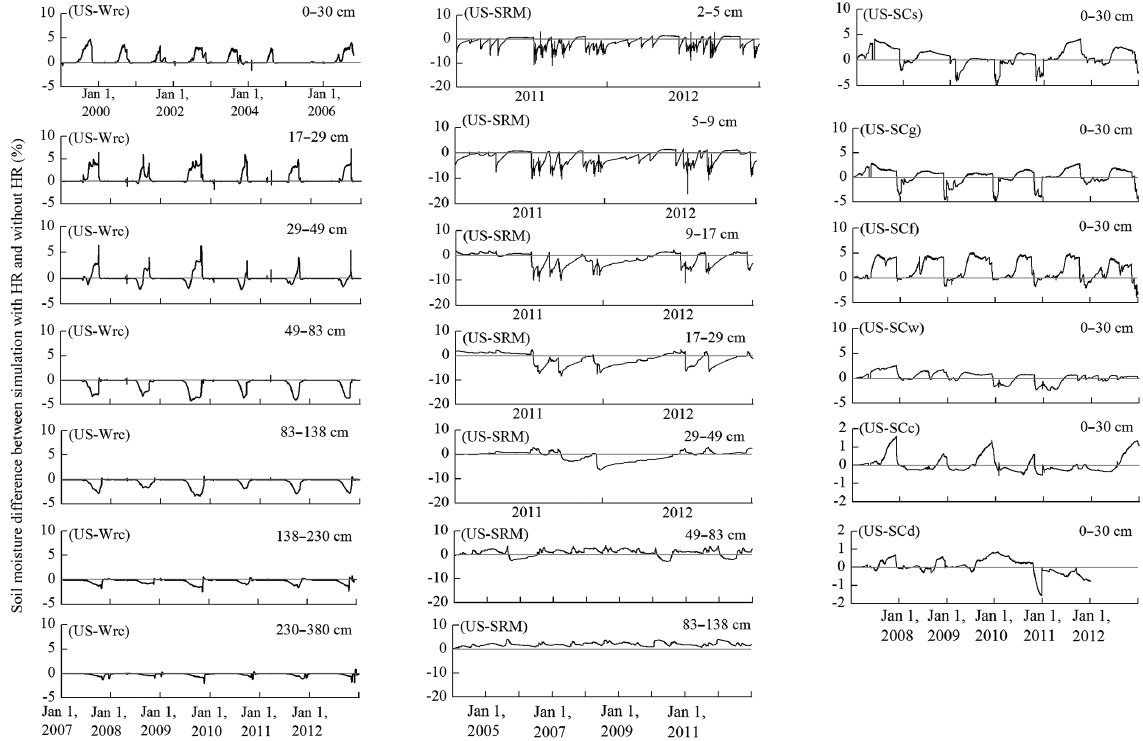
Figure 3. Soil moisture difference between simulations with HR and without HR at each site. Labels at the upper right corner of each panel show the depths of simulated soil moisture. Table 6. Modeled contribution of HR to ET during dry periods for all simulation years (mean ± SD, columns 3–6).